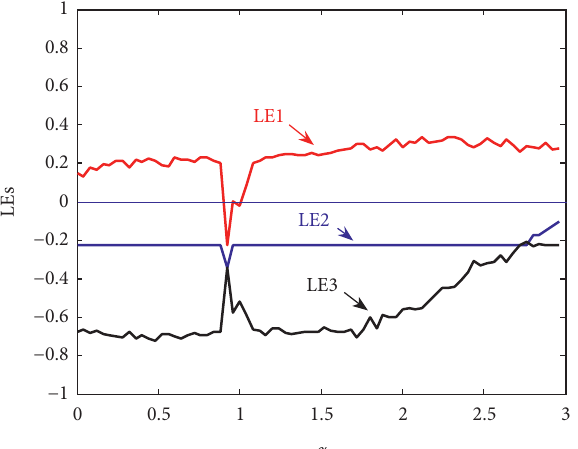
Figure 1: Lyapunov spectrum versus α when a � 1, b � 1.14, c � 2.93, d � 1.3, e � 0.21, f � 0.1, g � 0.35, h � 2, β � 0.2, c � 0.5.